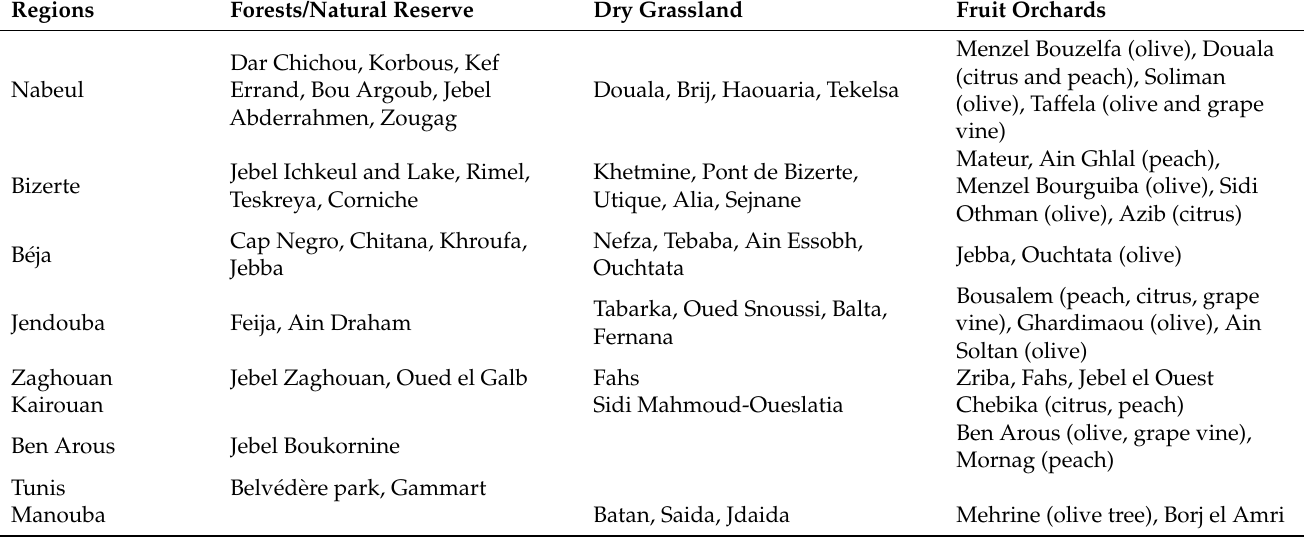
Table 1. Prospected regions and collecting sites from 2018 to 2021 in